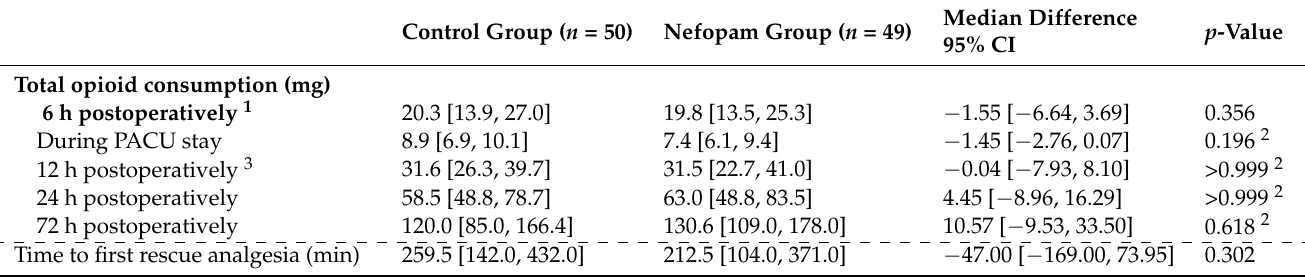
Table 2. Postoperative analgesic outcomes between the